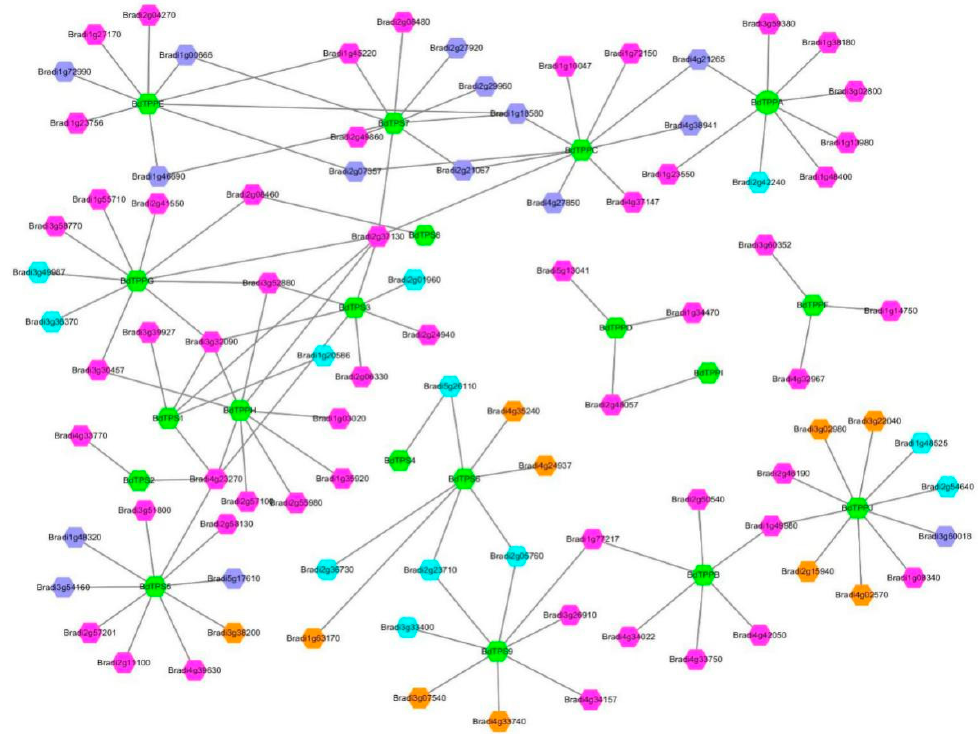
Figure 5. Prediction of the transcriptional regulatory network. The green hexagon represents BdTPS/BdTPP genes. Different colors represent different transcription factor families, with brilliant blue, dark blue, orange and purple hexagons indicating MYB, ERF, bZIP and 21 other transcription factor families, including B3, bHLH, C2H2, MIKC_MADS, TCP, LBD, NAC, BES1, EIL, Dof, E2F/DP, G2-like, Nin-like, CAMTA, CPP, Trihelix, ARF, C3H, GATA, TALE, and BBR-BPC family members.